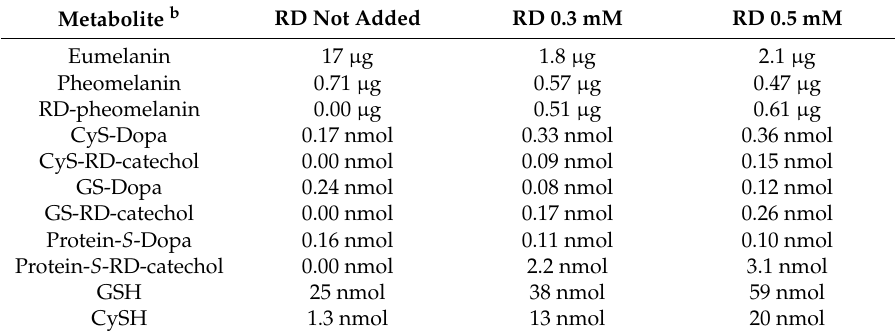
Table 1. Concentrations of Tyrosine- and RD-derived Metabolites in B16 Melanoma Cells Cultured for Three Days a